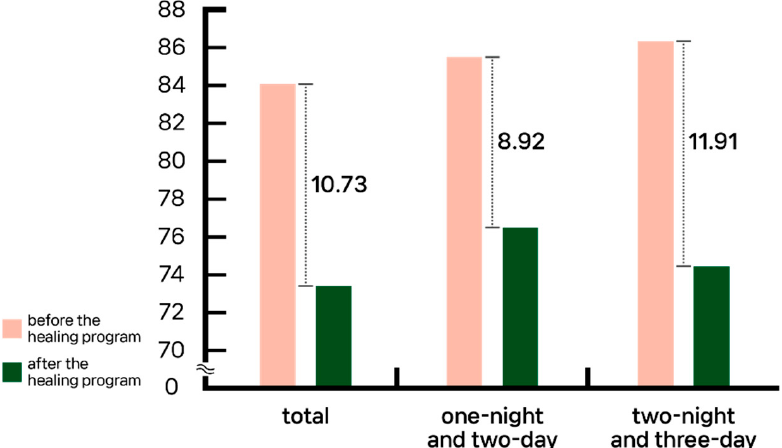
Figure 7. Comparison of the effects between the one-night and two-day and two-night and three-day programs for K-PSI-SF.